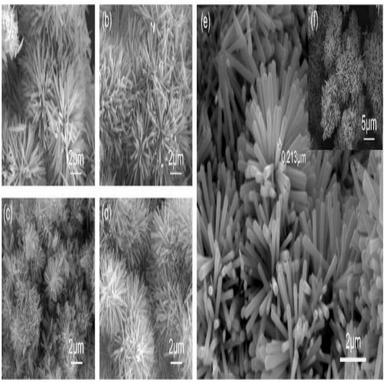
(a) SEM image of zinc oxide prepared by reacting at 60 ◦C for 4 h; (b) SEM image for the preparation of zinc oxide at 60 ◦C for 8 h; (c) SEM image of zinc oxide produced by reaction at 50 ◦C for 6 h; (d) SEM image that reacts 6 h to prepare zinc oxide at 70 ◦C; (e, f) SEM image of zinc oxide prepared at 60 ◦C for 6 h.